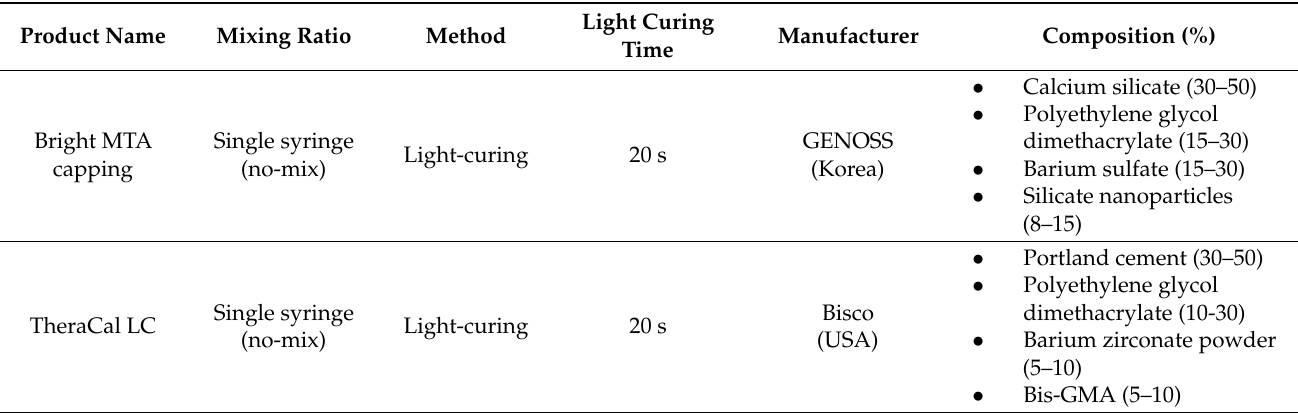
Table 1. Summary of the difference between mineral trioxide aggregate (MTA)-like material (TheraCal LC) and bright MTA